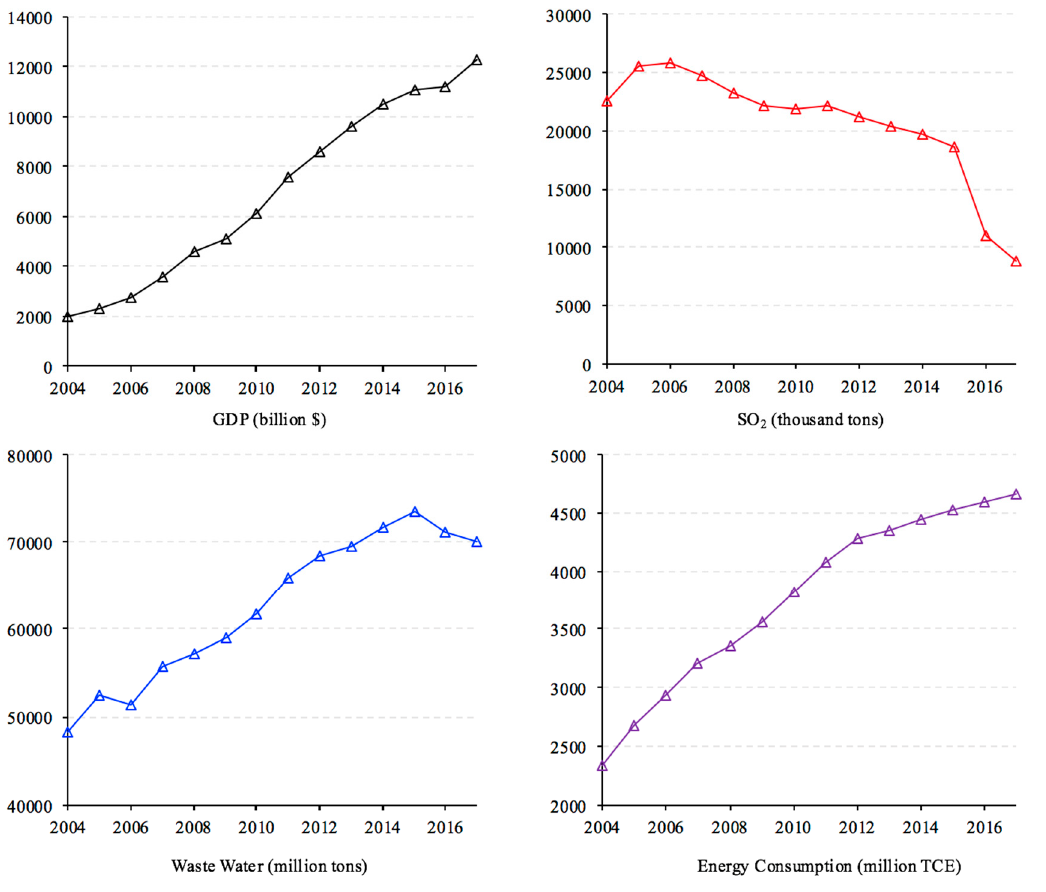
Figure 1. GDP, major pollutants and energy consumption of China for 2004–2017. The GDP data are from World Bank Open Data and measured in current US dollars. Data on SO 2 , wastewater and energy consumption are extracted from the China Statistical Yearbook.